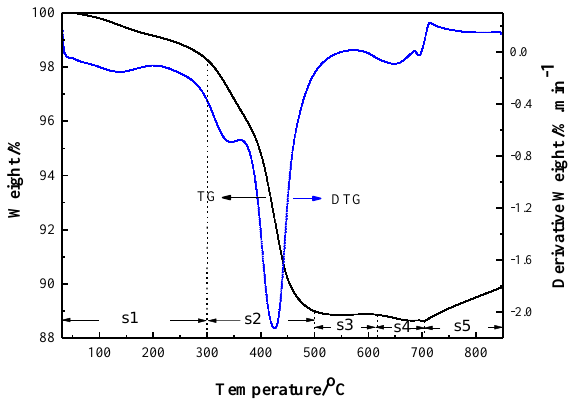
Figure 7. Thermogravimetric curve of the TiH 2 / Al green body by TGA.